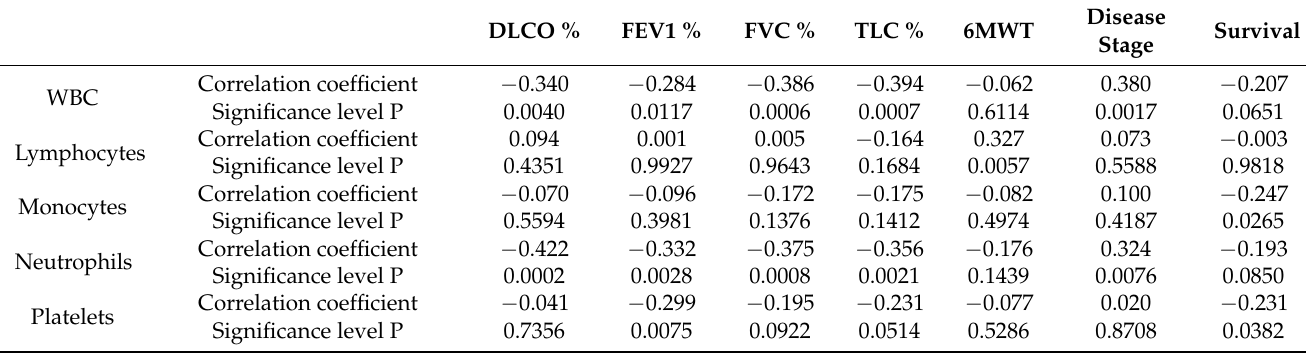
Table 2. Relationships between simple blood cell count indexes and clinical parameters.